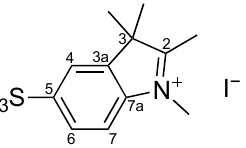
Figure 2. Structure of indolium salt 2 .